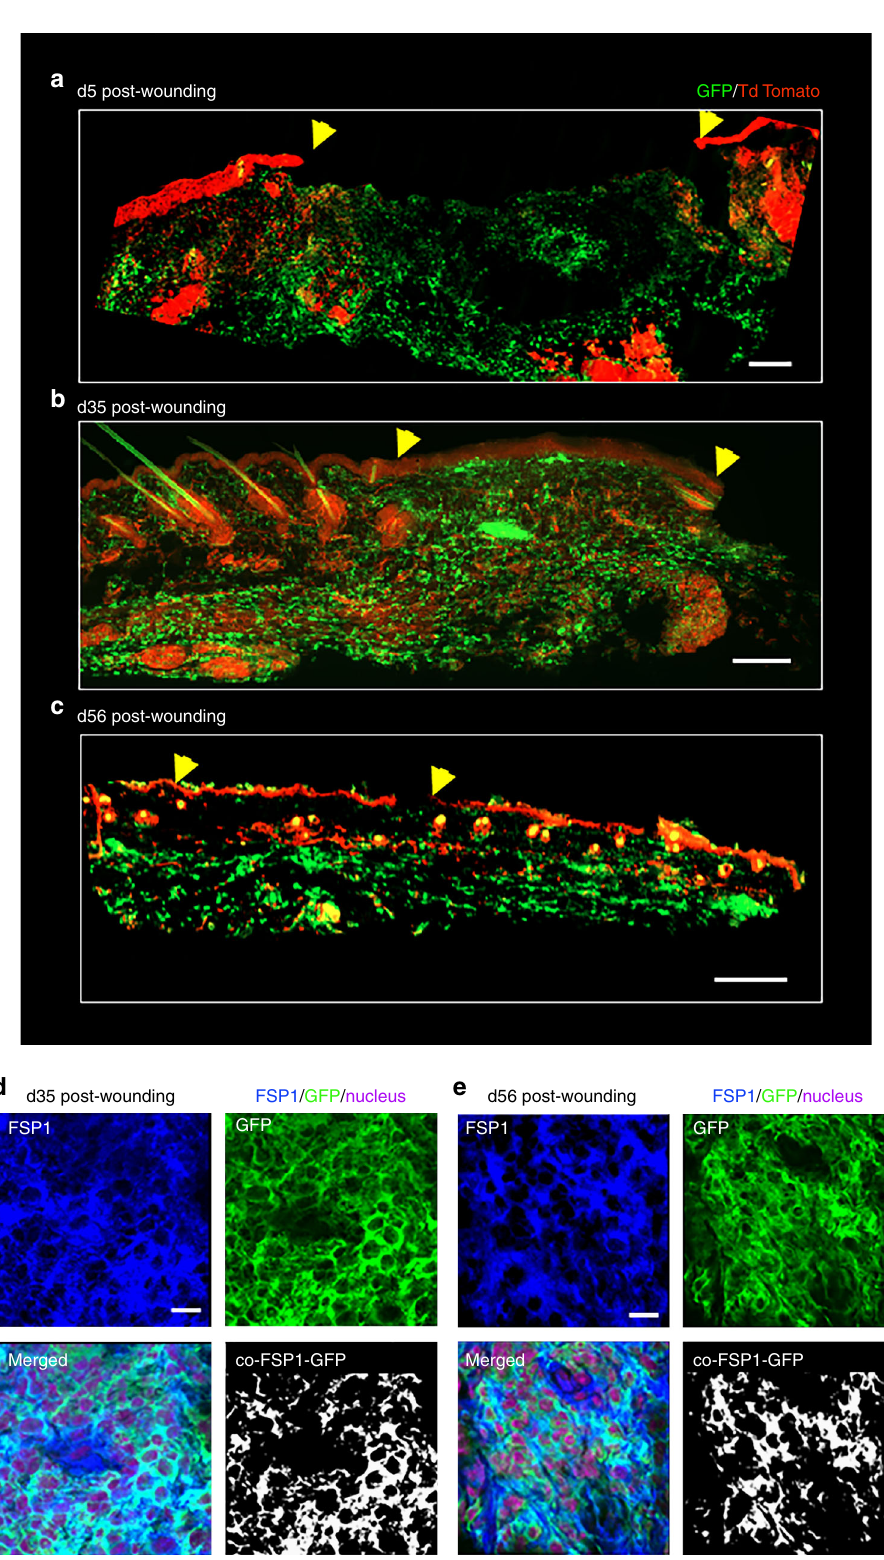
Fig. 2 Persistence of GFP + fi broblast-like cells at late remodeling phase post-wounding. a Conversion of wound-site macrophages (GFP + green) to fi broblast-like cells was abundant, particularly closer to newly forming epidermis, at the early phase (d5). Wound edge shown in yellow arrow head, scale bar = 200 µ m. b , c Such cells of myeloid origin (GFP + green) were observed to be present throughout granulation tissue in later phases d35 and d56. Wound edge shown in yellow arrow head, scale bar = 200 µ m. d , e FSP1 (blue) immunostaining of d35 and d56 wounds from LysM Cre Rosa mT/mG mice. Colocalization of FSP1 with GFP + cells, n = 5, scale bar = 10 µ